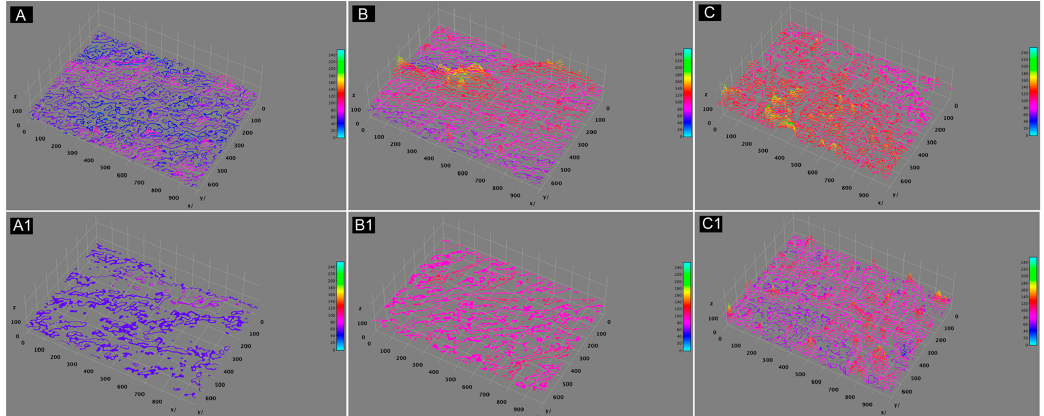
Figure 5. ( A , A1 ) show the 3D analysis of the surface roughness and its reduction in group A (glycine), non treated in image ( A ) and treated in image ( A1 ). ( B , B1 ) show the 3D analysis of the surface roughness and its reduction in group B (erythritol), non treated in ( B ) and treated in ( B1 ). ( C , C1 ) show the 3D analysis of the surface roughness and its reduction in group C (sodium bicarbonate), non treated in ( C ) and treated in ( C1 ).